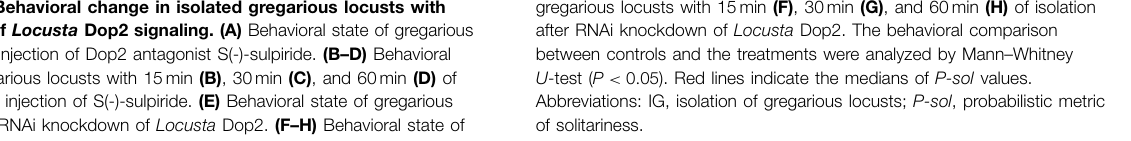
gregarious locusts with 15min (F) , 30min (G) , and 60min (H) of isolation after RNAi knockdown of Locusta Dop2. The behavioral comparison between controls and the treatments were analyzed by Mann–Whitney U -test ( P < 0 . 05 ). Red lines indicate the medians of P-sol